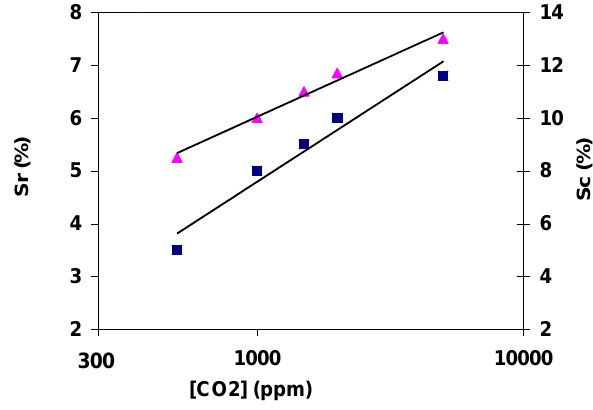
Figure 5. Sensitivity to carbon dioxide within a range 500 to 5,000 ppm, measured at 300  C and 40% RH, in terms of resistance change (Sr) and capacitance change (Sc).